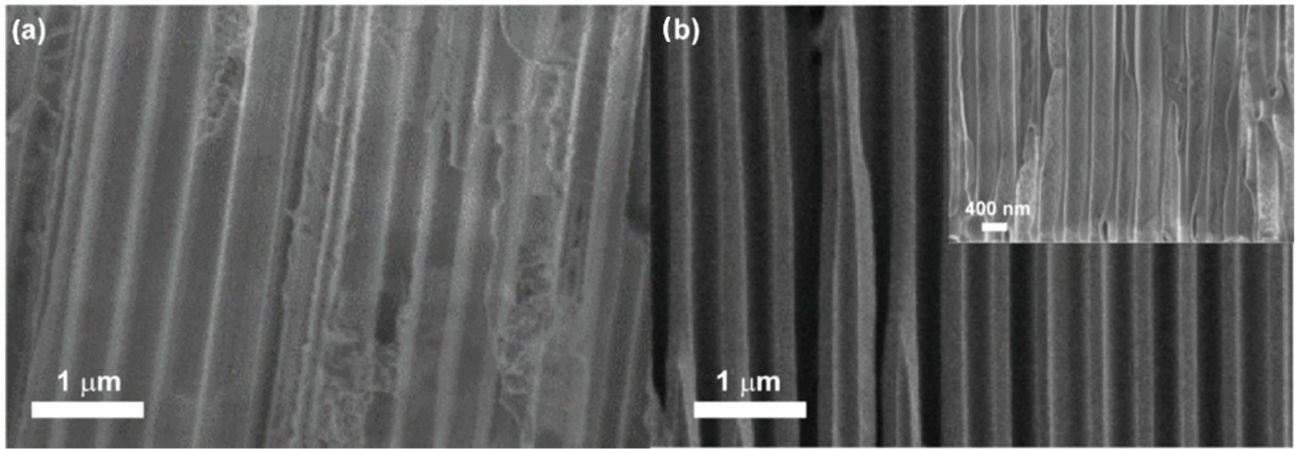
Figure 3. SEM data for AAO/PANI with 3D architecture obtained ( a ) without centrifugation; ( b ) with centrifugation. ( b ) with